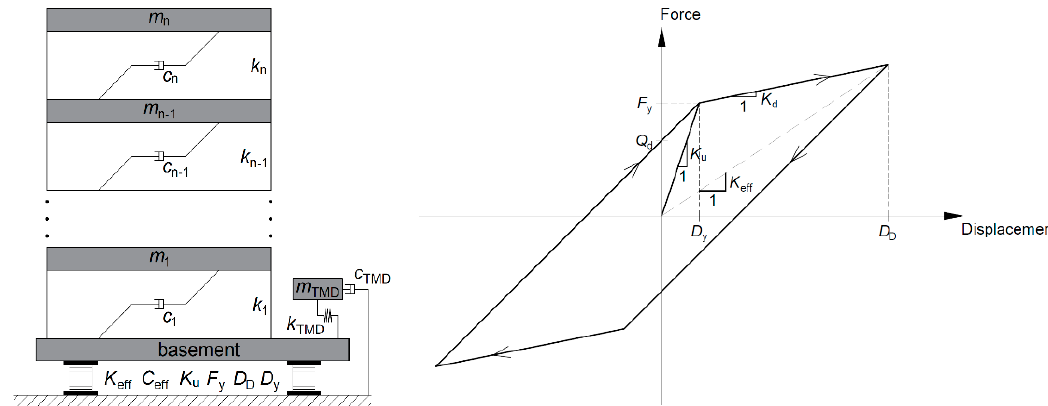
Figure 1. Schematic model of a building with a hybrid control system (left) and the bi-linear force–displacement relationship of the high-damping rubber bearing [34] (right). Table 1. Specifications of models of buildings equipped with seismic isolation devices. Building